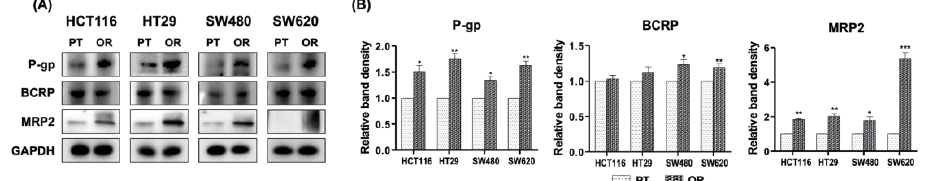
Figure 2. ( A ) Effects of oxaliplatin resistance on the expression of drug efflux pumps. Expression of P-gp and BCRP in parental (PT) and oxaliplatin-resistant (OR) colorectal cancer cells of HCT116, HT29, SW480 and SW620 was determined by immunoblot analysis. ( B ) Graphical analysis of band intensities normalized for protein loading with GAPDH. Columns and error bars represent means ± standards deviation of immunoblot band intensities of 3 separate protein preparations. * p < 0.05; ** p < 0.01; *** p < 0.001. P-gp, P-glycoprotein; BCRP, breast cancer resistance protein; MRP2, multi- drug resistance-associated protein 2; GAPDH, glyceraldehyde 3-phosphate dehydrogenase.